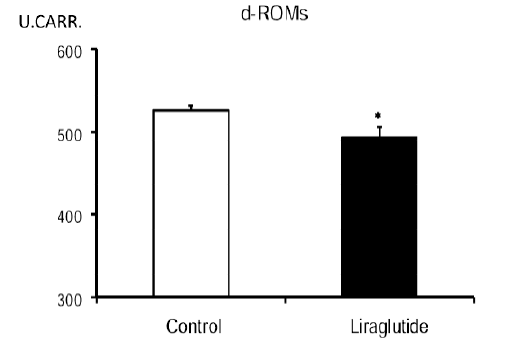
Figure 4. Reduced oxidative stress in liraglutide-treated rats. The graph shows significant reduction in level of d-ROMs in liraglutide-treated rats. * p < 0.05 vs. control group.